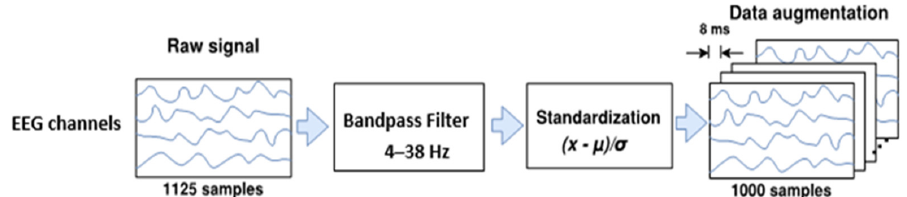
Figure 1. The raw EEG preprocessing and data augmentation.